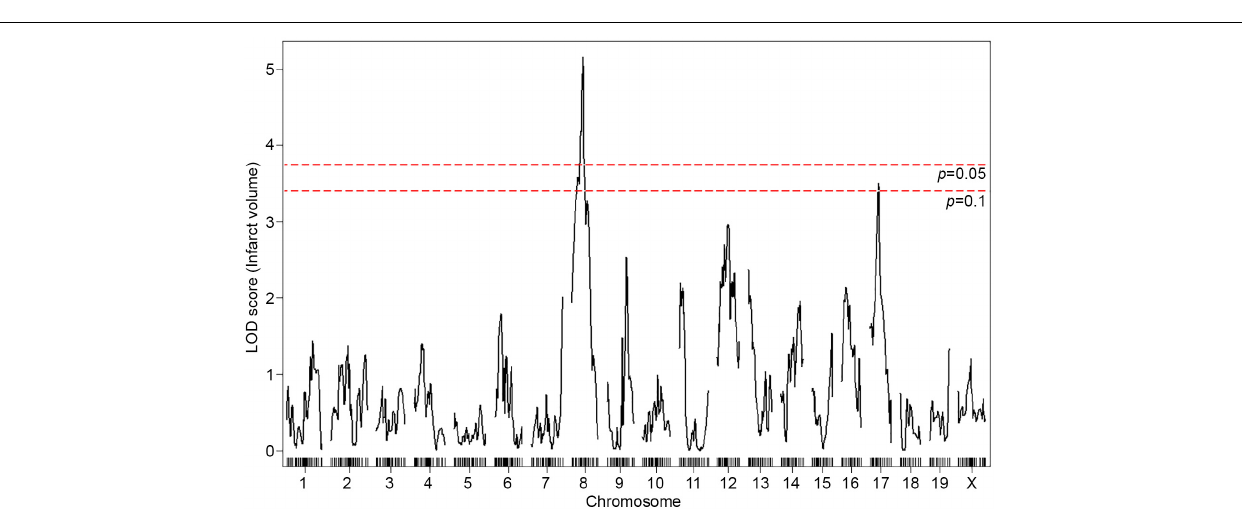
FIGURE 2 | A locus for infarct volume is mapped in the F2 progeny between B6 and WSB. The graph presents the analysis of a genome-wide QTL mapping scan for infarct volume measured 24 h after pMCAO using 376 F2 animals (B6 and WSB). Chromosomes 1 through X are represented numerically on the x -axis and the y -axis represents the LOD score. The significant ( p < 0.05) level of linkage was determined by 1,000 permutation tests. Only a single genomic region on Chr 8 displays significant linkage to infarct volume with a LOD score of